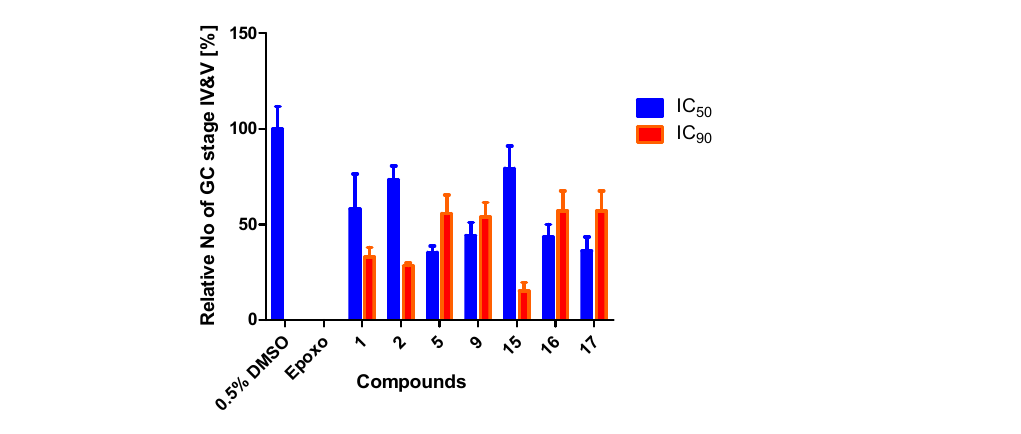
Figure 3. Effect of organosulfur compounds on gametocyte development. Cultures rich in stage II gametocyte were incubated with compounds at IC 50 and IC 90 concentrations for 2 d, and again cultivated for another 7 d with daily replacement of medium. The numbers of stage IV and V gametocytes were determined from Giemsa smears and normalized to 0.5% v / v DMSO treatment which served as negative control (set to 100%). Epoxomicin (Epoxo) at 60 nM served as positive control. 3.5. The Compounds Exhibit No Hemolytic or Less Cytotoxic Effect on Human Cells To assess if the compounds have unexpected side effects by lysing non-infected erythrocytes, a hemolysis test was performed. Fresh erythrocytes were incubated with 1 , 2 , 5 , 9 , 15 , 16 , and 17 at IC 50 and IC 90 concentrations for 48 h at 37 °C and hemolysis was determined by measuring the amount of hemoglobin released in the cultures spectrophotometrically. Erythrocytes treated with 0.15% w / v saponin were used as the positive control, while erythrocytes incubated with 0.5% v / v DMSO or medium served as the negative control. The assay demonstrated no hemolytic effect of all compounds at IC 50 and IC 90 concentrations with no differences in extracellular hemoglobin content measurable between compound-treated and 0.5% v / v DMSO-treated erythrocytes (Figure 4a). The compounds were further investigated for their cytotoxicity on Hela cells using the MTT assay which measures metabolic activity. Cells were cultured for 72 h with compound 1 , 2 , 5 , 9 , 15 , 16 , and 17 at different concentrations, and cell viability was determined using the MTT assay and compared with that of 0.05% v / v DMSO which served as the control (set to 100% viability). The results show that at a concentration of about 25 µ M more than 90% of the cells were viable, while at 50 µ M more than 60% cell viability was obtained (Figure